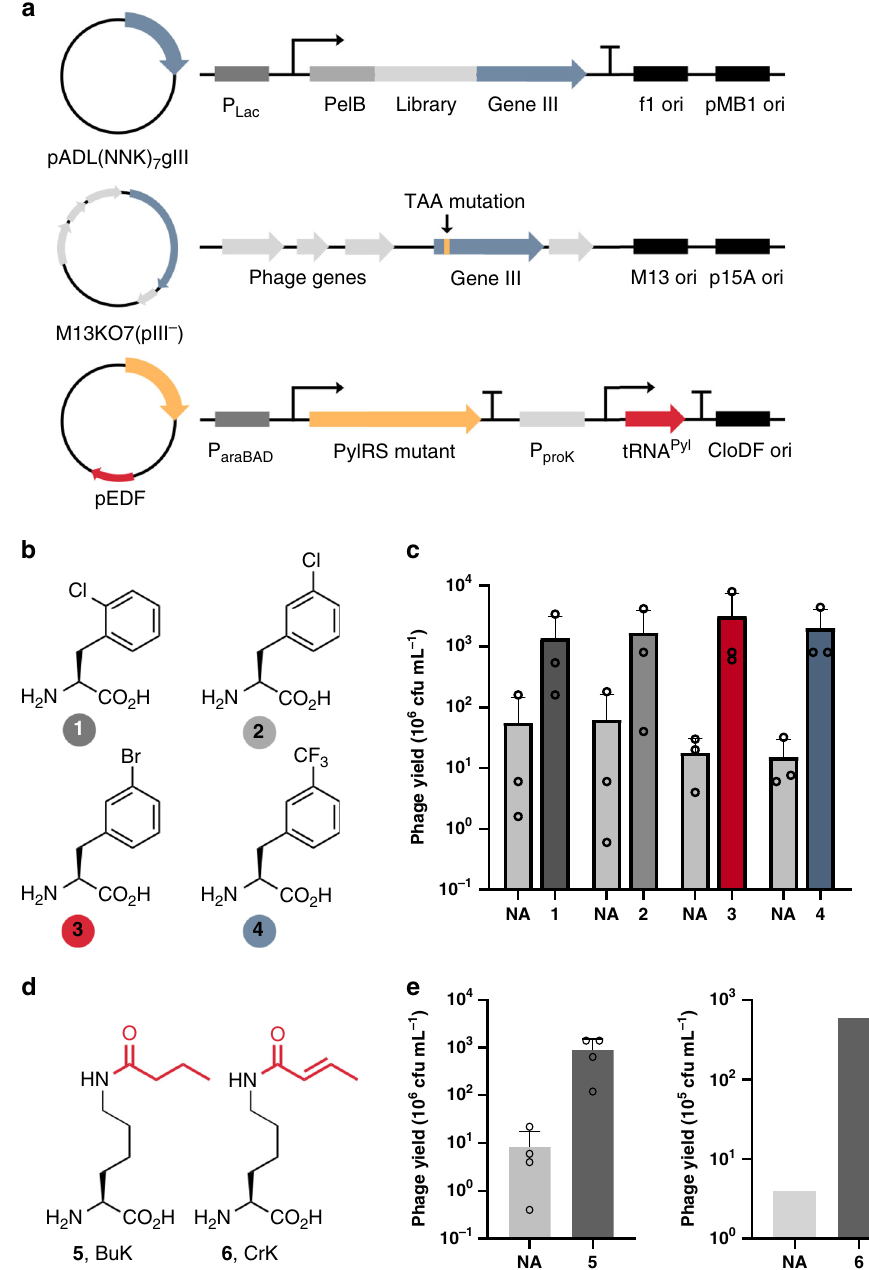
Fig. 4 The genetic incorporation of ncAAs into a phage-displayed peptide library. a A schematic representation of the three-plasmid system used to incorporate ncAAs into the peptide library. b The structures of phenylalanine derivatives 1 – 4 . c Phage yield in the presence and absence (NA) of 4 mM ncAAs 1 – 4 . The yield is displayed in millions of colony-forming units per milliliter of culture media. Error bars represent one standard deviation of the mean of three independent experiments ( n = 3). d The structures of two post-translationally modi fi ed lysines, 5 and 6 . e Phage yield in the presence and absence (NA) of 5 and 6 . The yield is displayed in millions or hundreds of thousands of colony-forming units for compounds 5 and 6 , respectively. Error bars represent one standard deviation of the mean of four independent experiments ( n = 4). Data for the incorporation of ncAAs are available in the Source Data